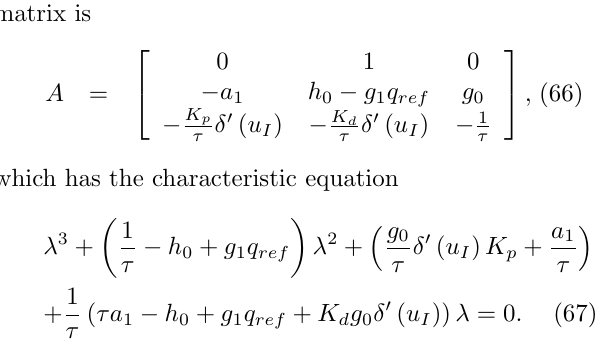
Figure 5: Simulations of PI stabilization at a pressure in the unstable region p ref = 4 . 498 using PI controller.